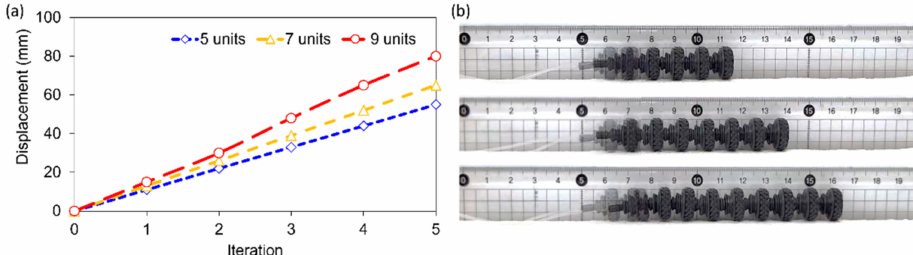
Figure 5. Characteristics according to the number of modular soft actuator units. ( a ) Displacement changes according to the operation cycle of MSSR with different number of units on the rough surface paper towel that easily has anisotropic frictional force. ( b ) Initial and final positions of the captured MSSR after one cycle.